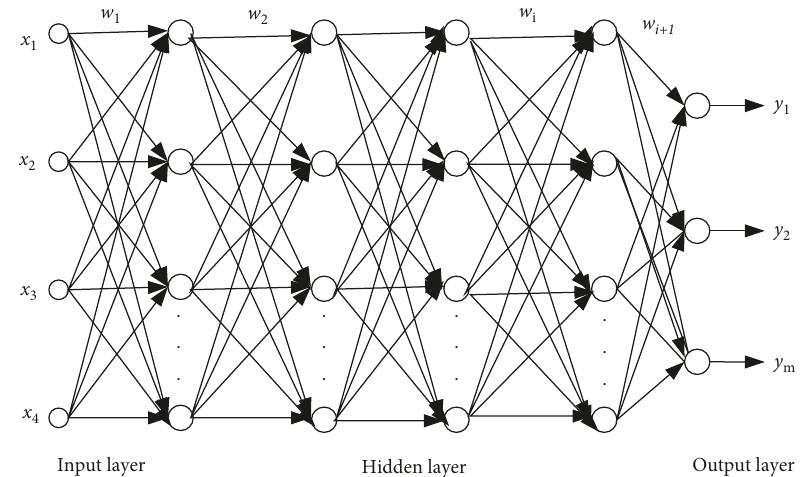
Figure 6: Neural network image recognition model.